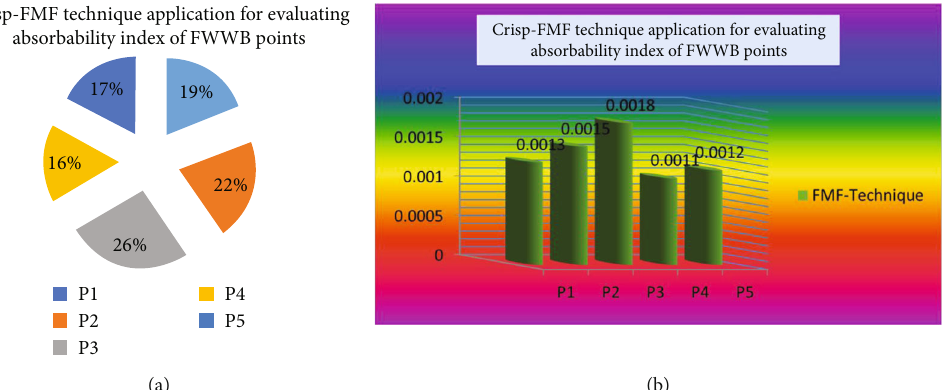
Figure 2: Crisp-FMF application for evaluating absorbability index of respective FWWB points vs. FsCS, shown by (a) pie and (b) bar